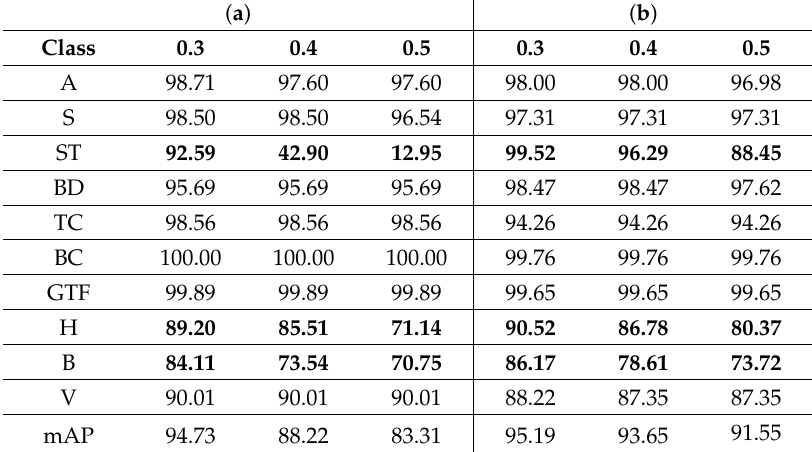
Table 5. ( a ) is the results of the FPN + MS experiments using three di ff erent IoU values, getting big di ff erences of results for each di ff erent IoU. The total e ff ect is only from 4.91% to 11.42%. ( b ) is the results of the SD-MS experiments, and the e ff ect of IoU is very weak. The total e ff ect is only from 2.1% to